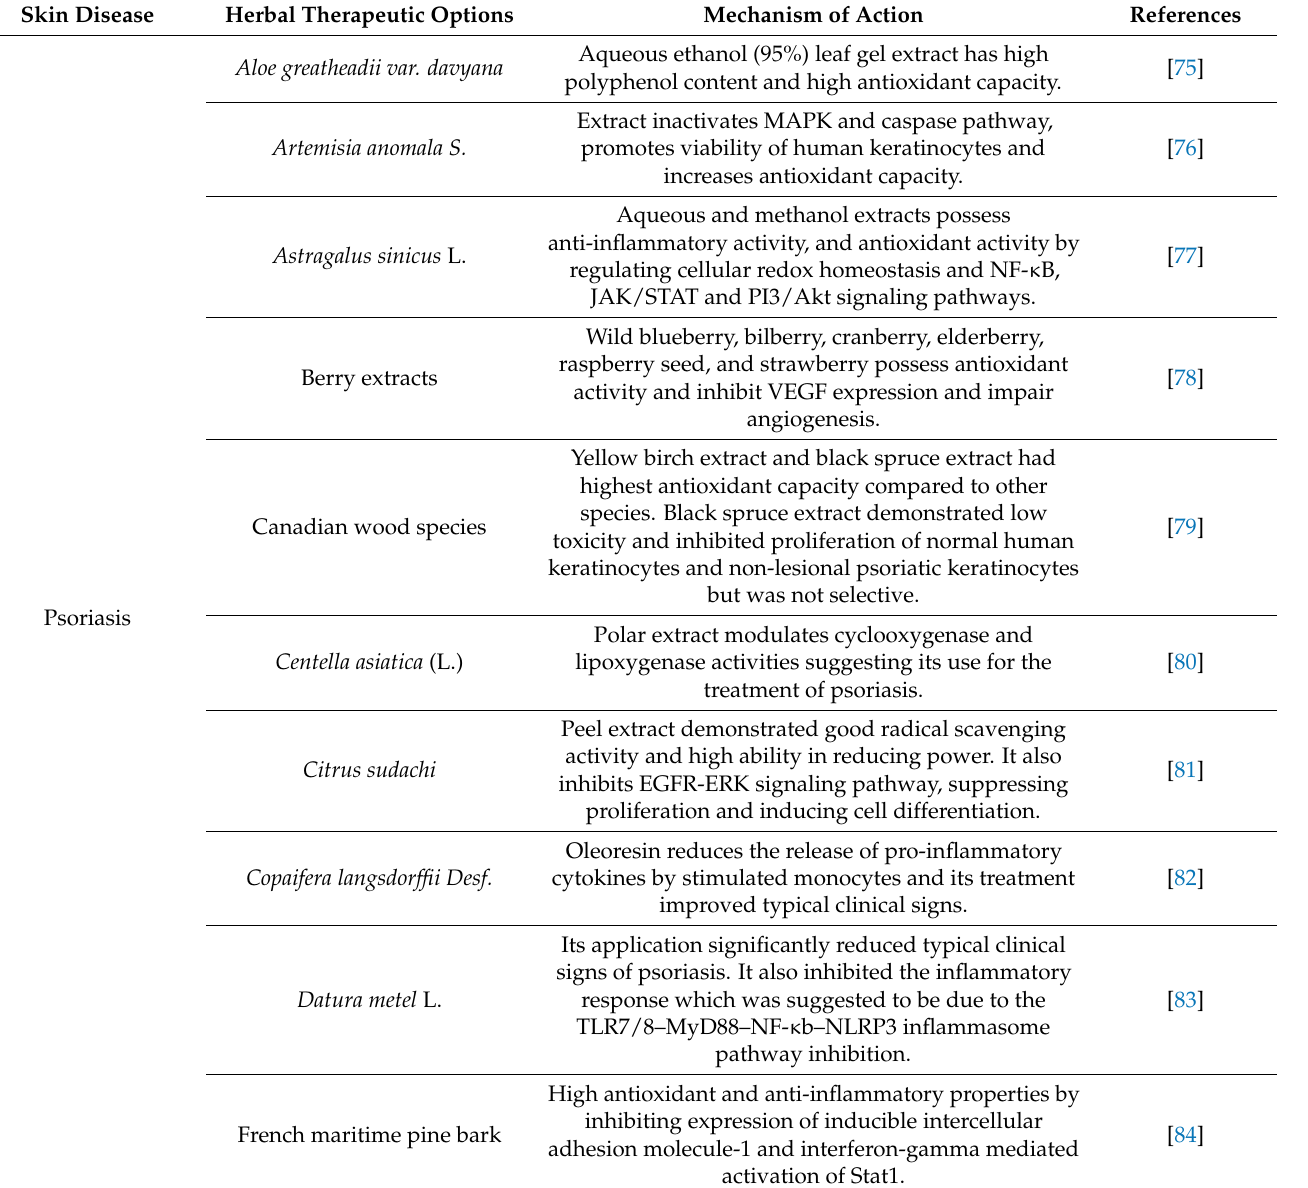
Table 2. Adjuvant therapeutic approach for the treatment of cutaneous diseases. Skin